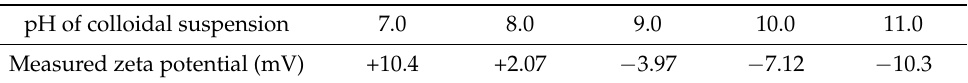
Table 4. The pH dependence of zeta potential of chitin